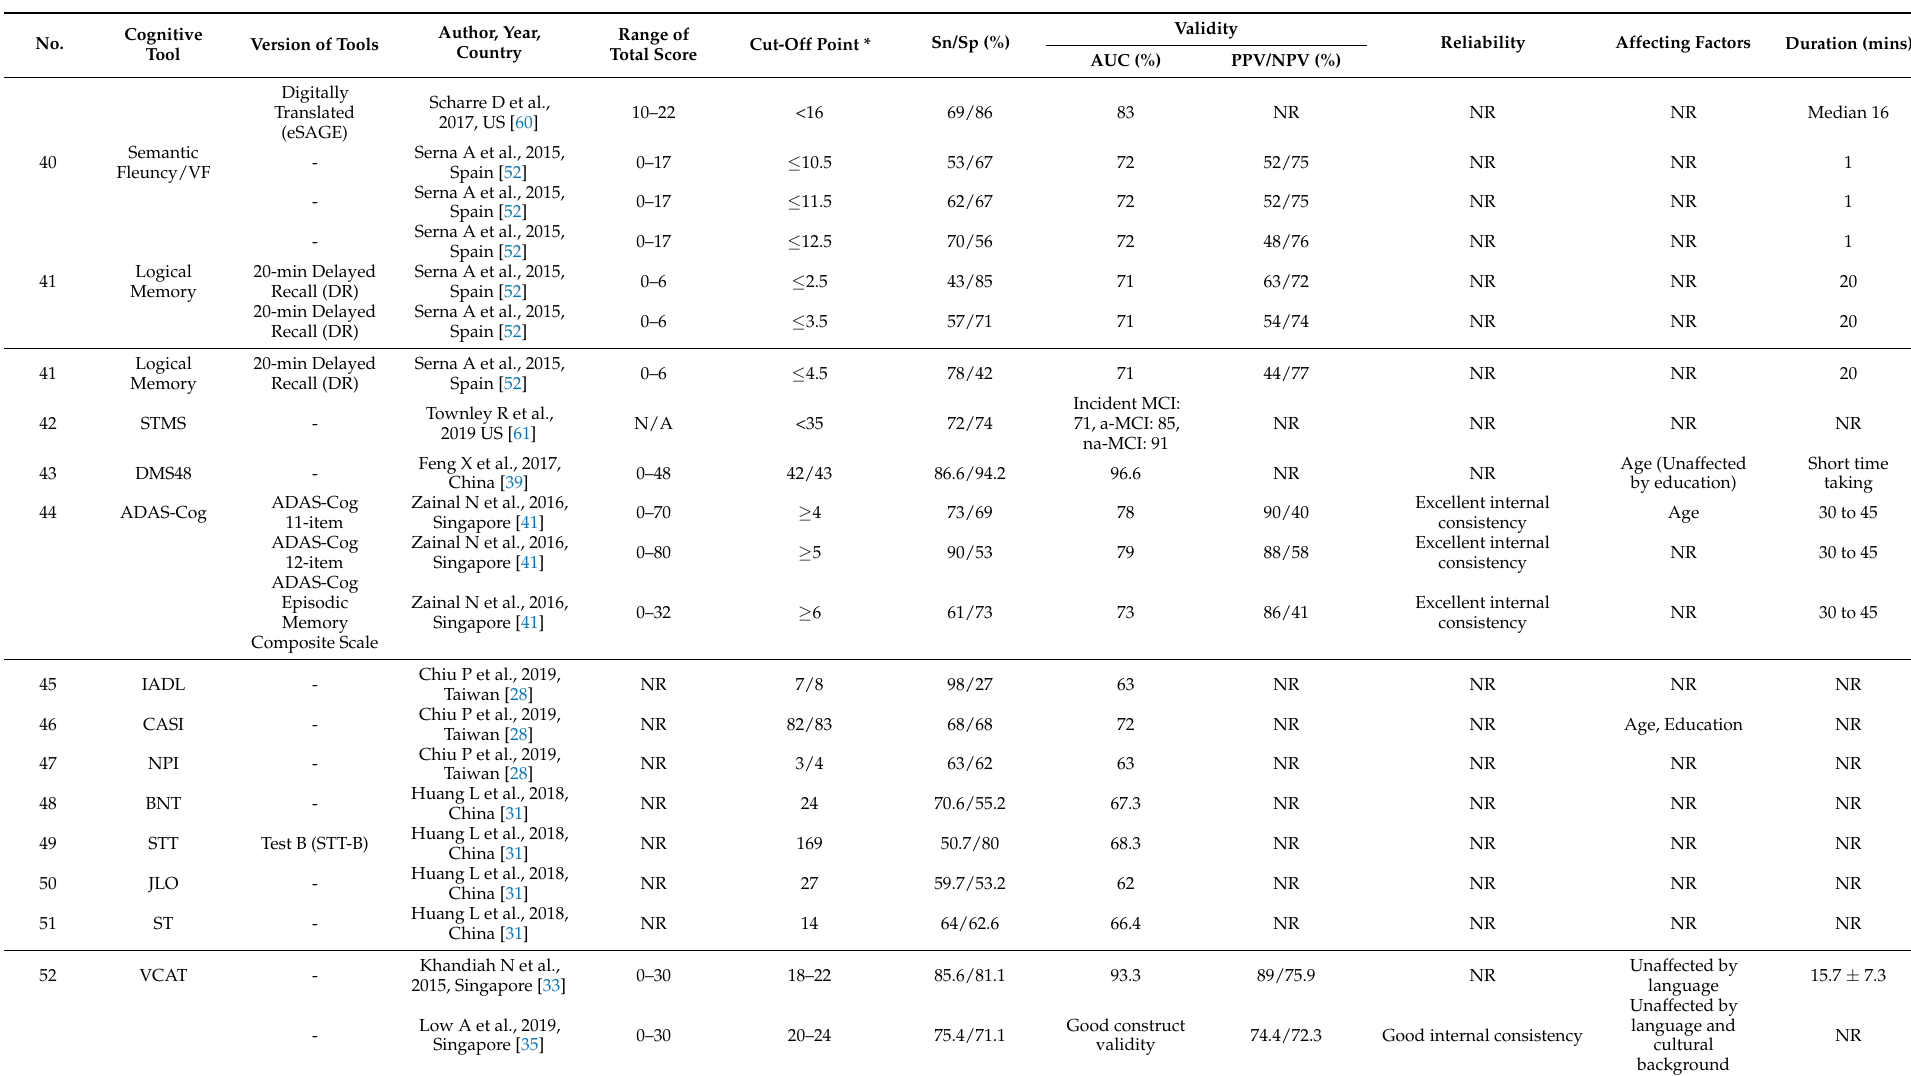
Abbreviations list for Table 4: AD: Alzheimer’s Disease; Sn/Sp: Sensitivity/Specificity; AUC: Area Under Curve; PPV/NPV: Positive Predictive Value/Negative Predictive